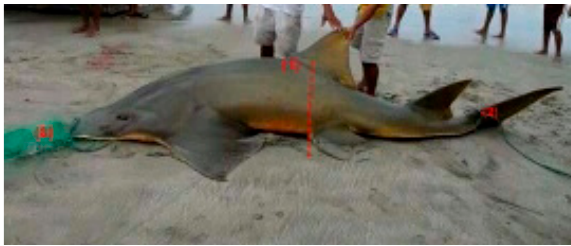
Figure 2. Sawfish landed dead at La Cruz, Tumbes, on 22 January